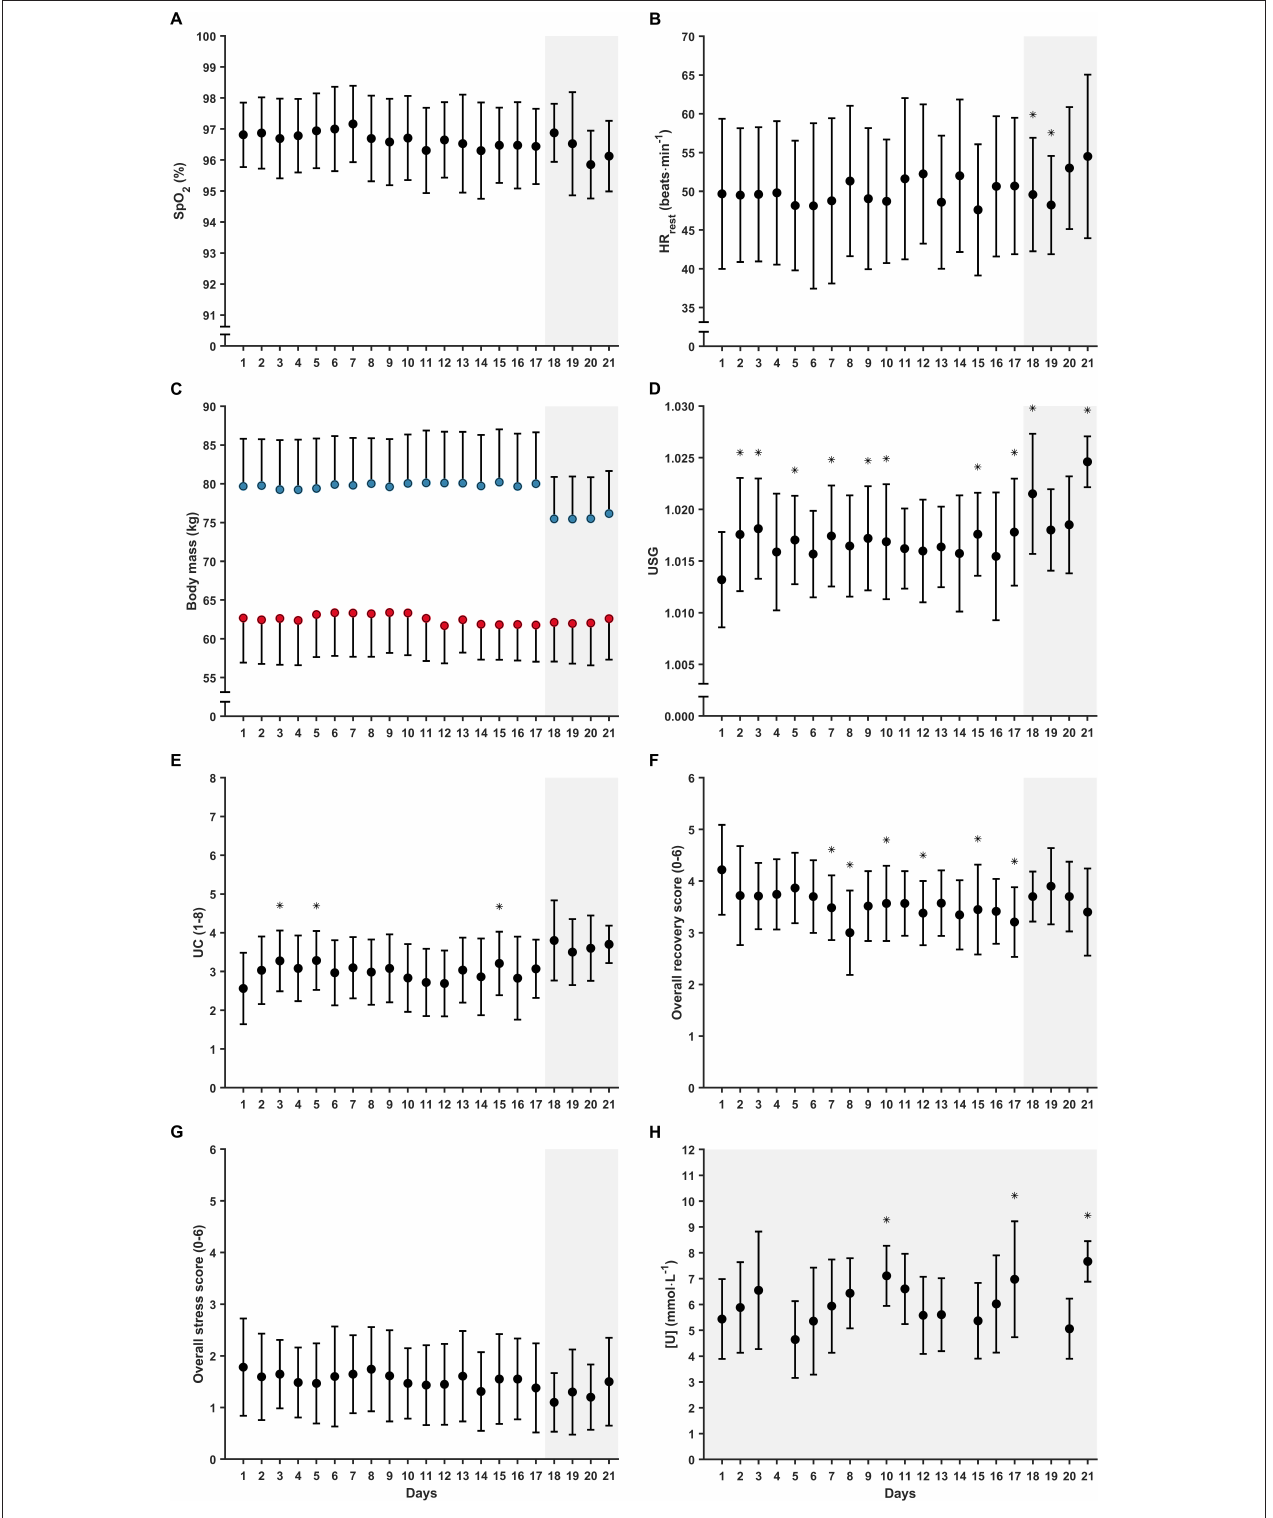
FIGURE 3 | Daily (mean ± SD) (A) resting peripheral oxygen saturation (SpO 2rest ); (B) resting heart rate (HR rest ); (C) body mass; (D) urine specific gravity (USG); (E) urine color (UC); (F) overall recovery; (G) overall stress; and (H) blood urea nitrogen concentration ([U], biathletes only) during the training camp. Full circles, all participants; red circles, women; blue circles, men. Shaded areas indicate biathletes only. *Significant effect of time modeled as a discrete variable (i.e., in relation to day 1 of the camp; p < 0.05).